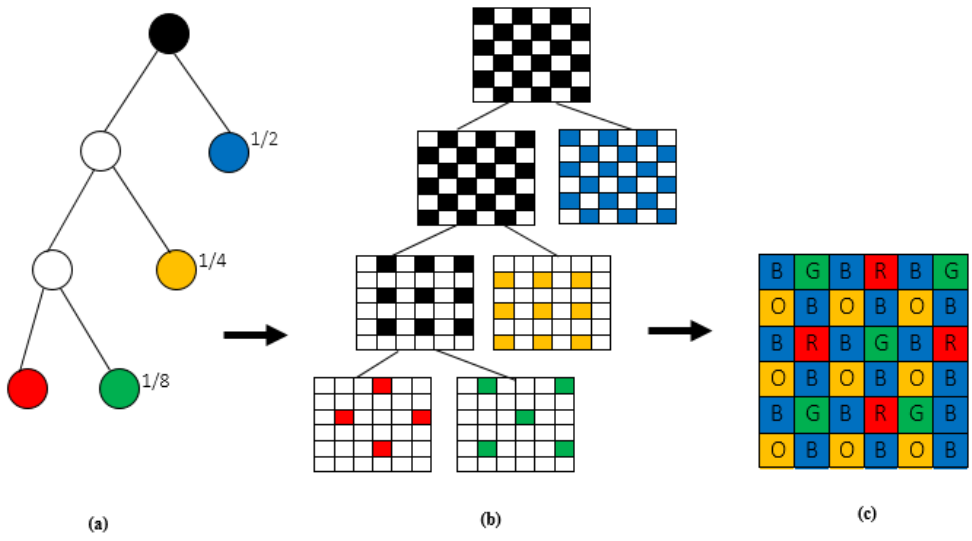
Figure 1. Four-band MSFA configuration: ( a ) binary tree considering appearance probabilities ( b ) decomposition and subsampling processes ( c ) MSFA configuration.